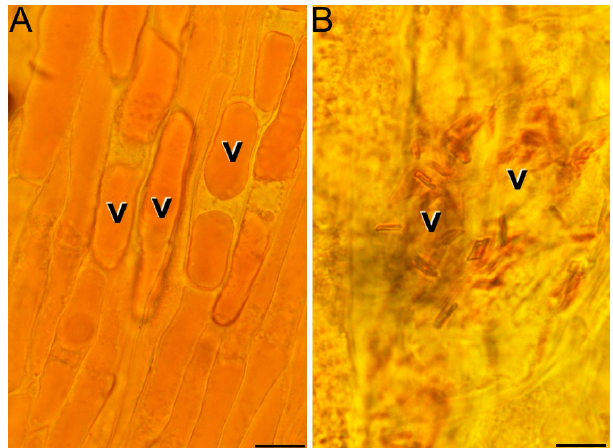
Figure 3. Presence of pigments, both soluble ( A ) and crystalline ( B ), in the vacuole (v) of plasmolyzed cells from red stigmas at anthesis. Bars: 20 µm.